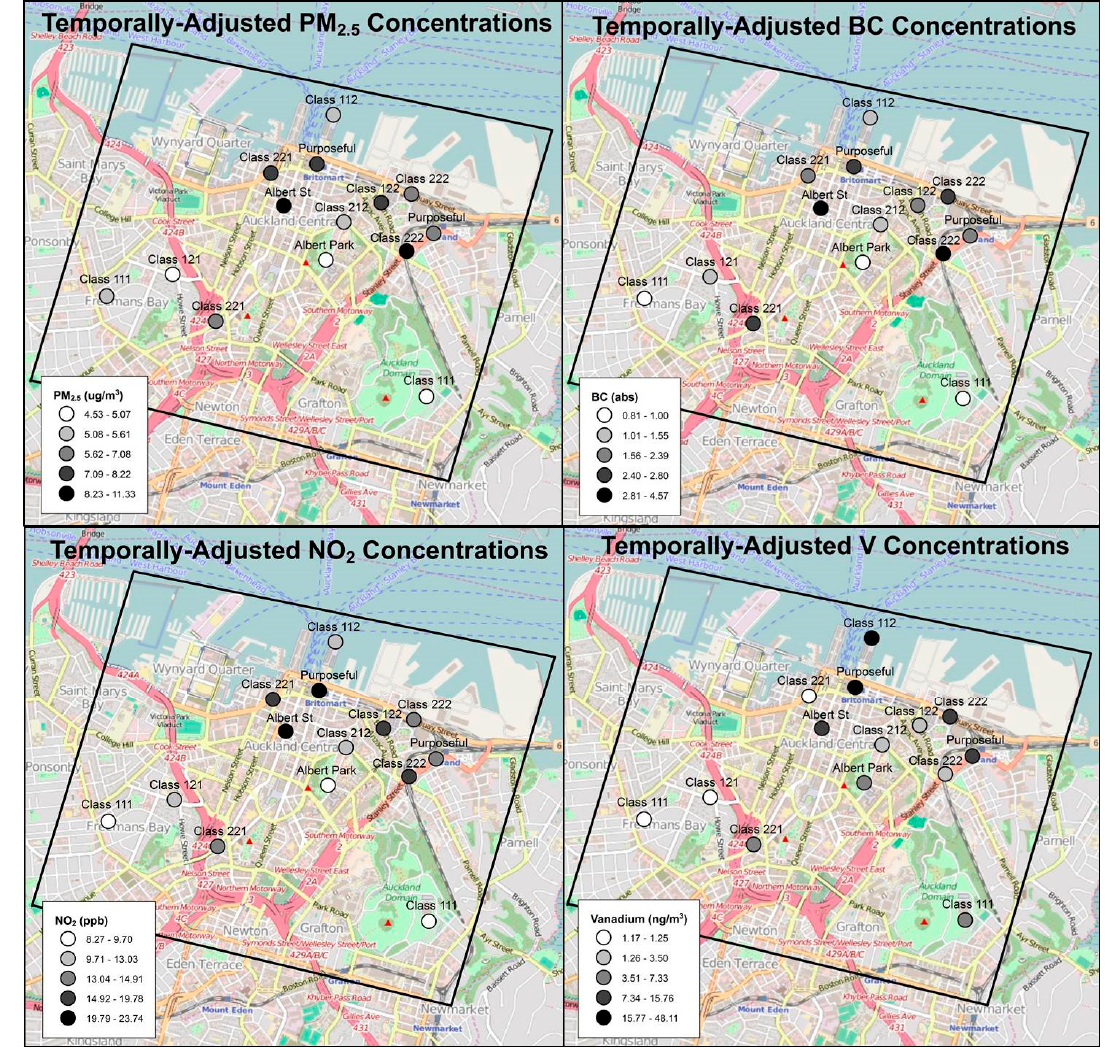
Figure 3. Temporally-adjusted PM 2.5 , BC, NO 2 , and V concentrations (in quintiles) across 14 monitoring sites.